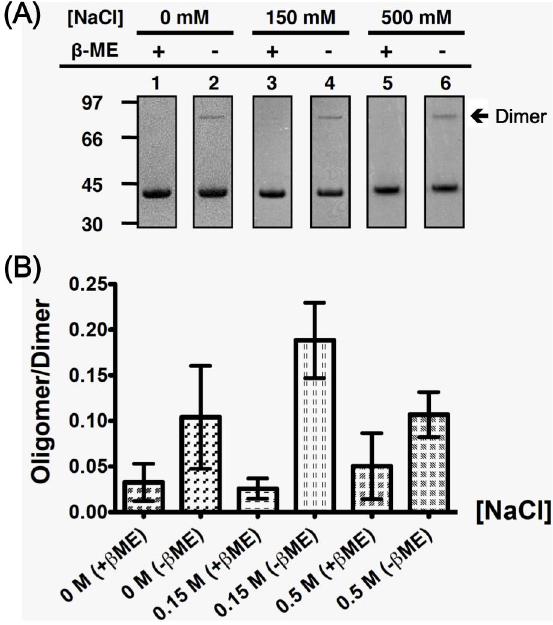
Figure 4. CTD acts as an oligomerization domain of DD. (A) Representative SDS-PAGE strips of DD Q290C mutant after disulfide trapping treatment. Number on the left marks the molecular weight of the markers. The arrow denotes the position of disulfide-linked di- domain on the gel. Unlike CTD Q290C , DD Q290C did not exhibit salt- dependent oligomerization as quantified in (B). The bars represent the average results from three independent experiments.